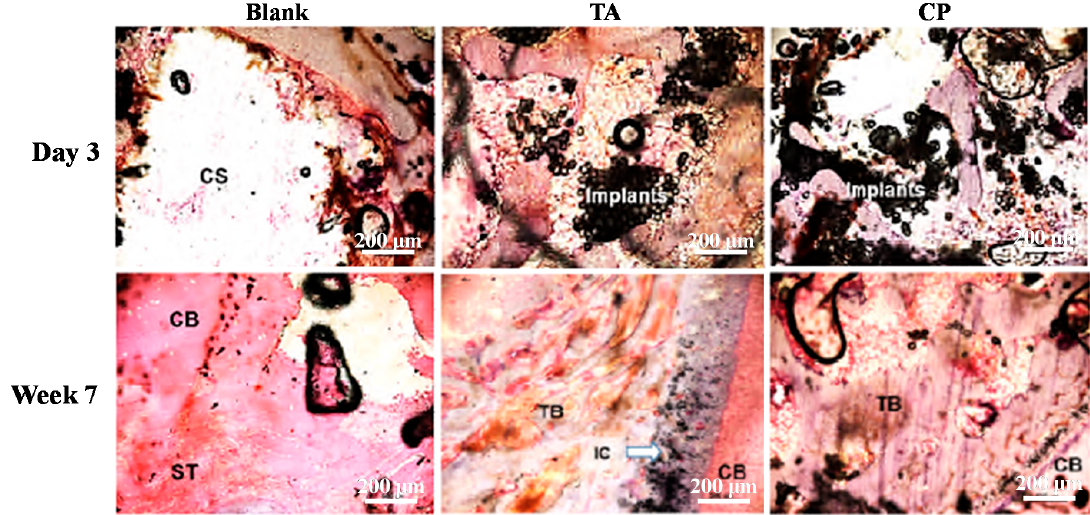
Figure 5. Histological images of α -CSH bioceramic at day 3 and week 7 after implantation. (Critical size defect: CS, cortical bone: CB, trabecula bone: TB, immune cell: IC, testing article: TA, commercial product: CP, and soft tissue: ST).